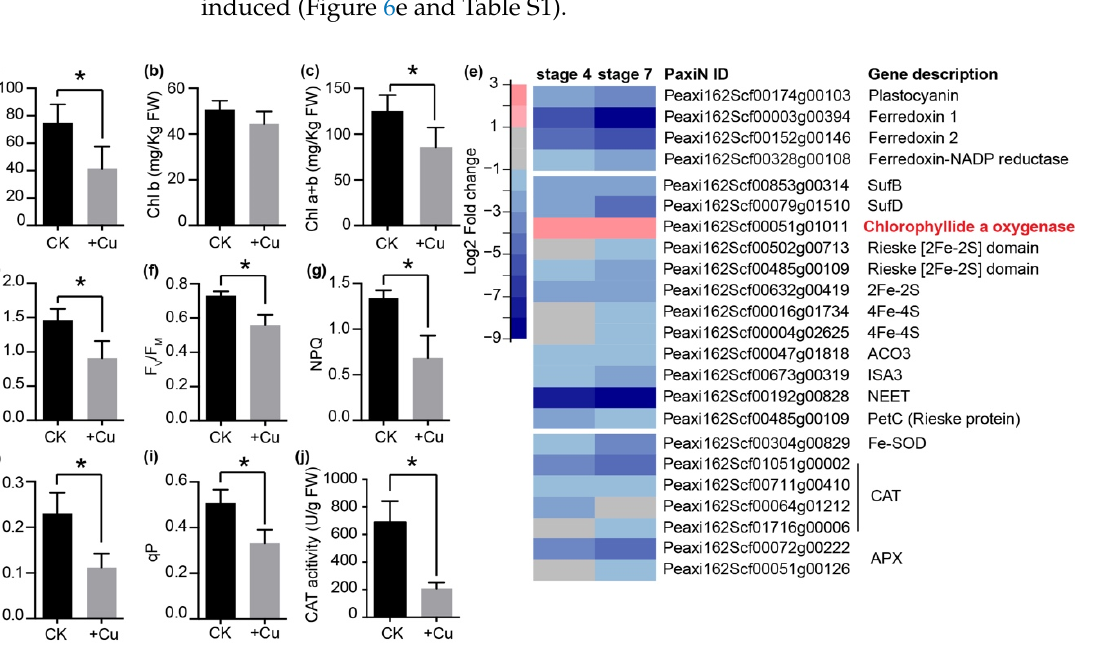
Figure 6. Effects of excess Cu treatment on photosynthesis in petunia petals. ( a – d ) Content of chlorophyll a ( a ), chlorophyll b ( b ), chlorophyll a+b ( c ) and chl a/b ratio ( d ) in stage 4 petunia petals. Bars are means ± SD ( n = 5 petals). ( e ) Expression profiles of Fe–S metabolism related genes under the GO:0051536 item, which were enriched in stage 4 and stage 7 petals. ( f ) F V /F M , maximum potential PS II efficiency; ( g ) NPQ, non-photochemical quenching value; ( h ) Φ PS(II), actual PS II efficiency; and ( i ) qP, photochemical quenching value was measured in stage 4 petals under excess Cu. Bars are means ± SD ( n = 6 petals). ( j ) CAT activity in petunia stage 4 petals upon Cu excess. Bars are mean ± SD ( n = 3). * indicates significant differences ( p < 0.05) using Tukey’s HSD test.